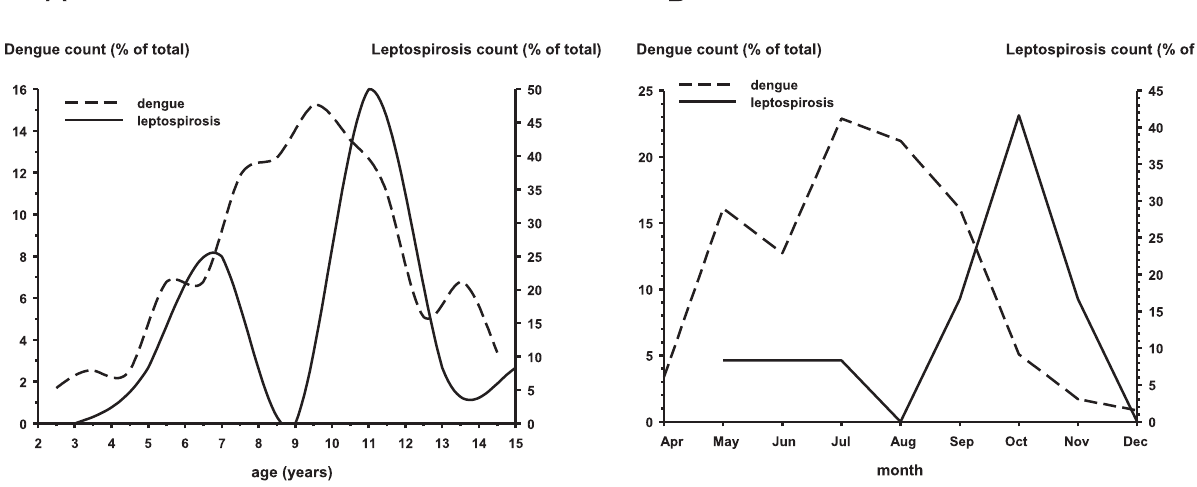
Figure 2. Ages and months of presentation for children with leptospirosis or dengue in Kamphaeng Phet, Thailand. (A) Age distribution of children presenting with leptospirosis ( n =12) or dengue ( n =118) in Kamphaeng Phet, Thailand. (B) Month of presentation of children with leptospirosis ( n =12) or dengue ( n =118) in Kamphaeng Phet, Thailand.